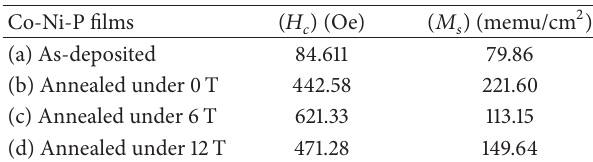
Table 1: Coercivity field (𝐻 𝑐 ) and saturation magnetization (𝑀 𝑠 ) of Co-Ni-P films before and after magnetic field annealing.